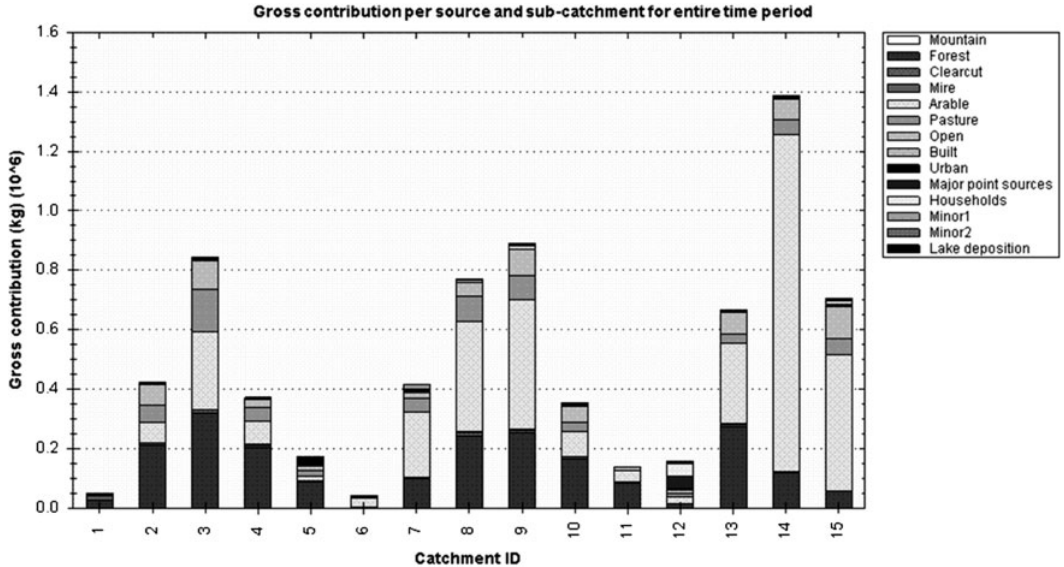
Fig. 8. N tot loads and source apportionment in Be¯rze River subcatchments (2000 (cid:2) 2010)